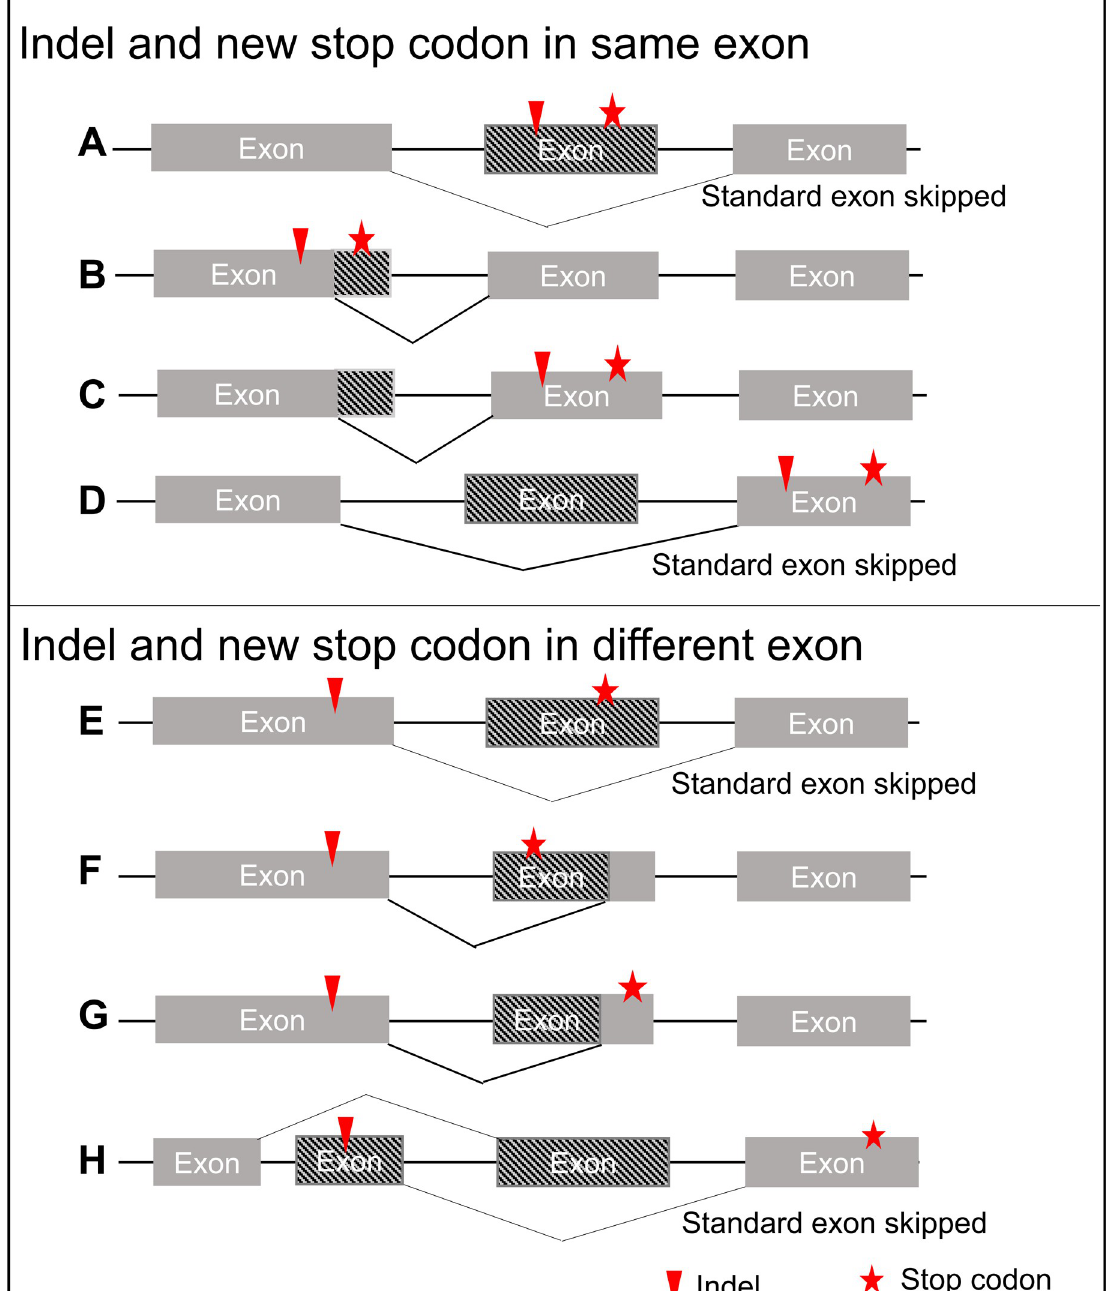
Fig 2. In-frame stop codons and modes of rescue. Different relationships between rescue junction and indel-introduced PTCs are shown. The red asterisks show the PTC introduced by the indels (red triangle) if not rescued. The polylines depict the rescue junctions which could either skip or compensate the PTC, resulted in preserving of original stop codons but with truncated proteins. (A-D) the indel and new PTC in the same exon (182 rescue events observed) (A) PTC skipped by standard exon skipping (5 rescue events); (B) PTC skipped by novel junction but not exon skipping (95 rescue events); (C) PTC not skipped but rescued by novel junctions (not exon skipping) (76 rescue events); (D) PTC not skipped but rescued by skipping of the exon before PTC (6 rescue events) (E-H) the indel and new PTC in different exons (84 rescue events observed) (E) PTC skipped by standard exon skipping (3 rescue events); (F) PTC skipped by novel junction but not exon skipping (40 rescue events); (G) PTC not skipped but rescued by novel junctions (not exon skipping) (38 rescue events); (H) PTC not skipped but rescued by skipping of the exon before PTC (3 rescue events). In (A), (B), (E), (F) the PTCs are excluded (n = 5+95+3+40 = 143 events), while (A) and (E) are through exon-skipping (n = 8 rescue events). In (C), (D), (G) and (H) the non-3n indels are compensated so the supposed PTCs will not actually